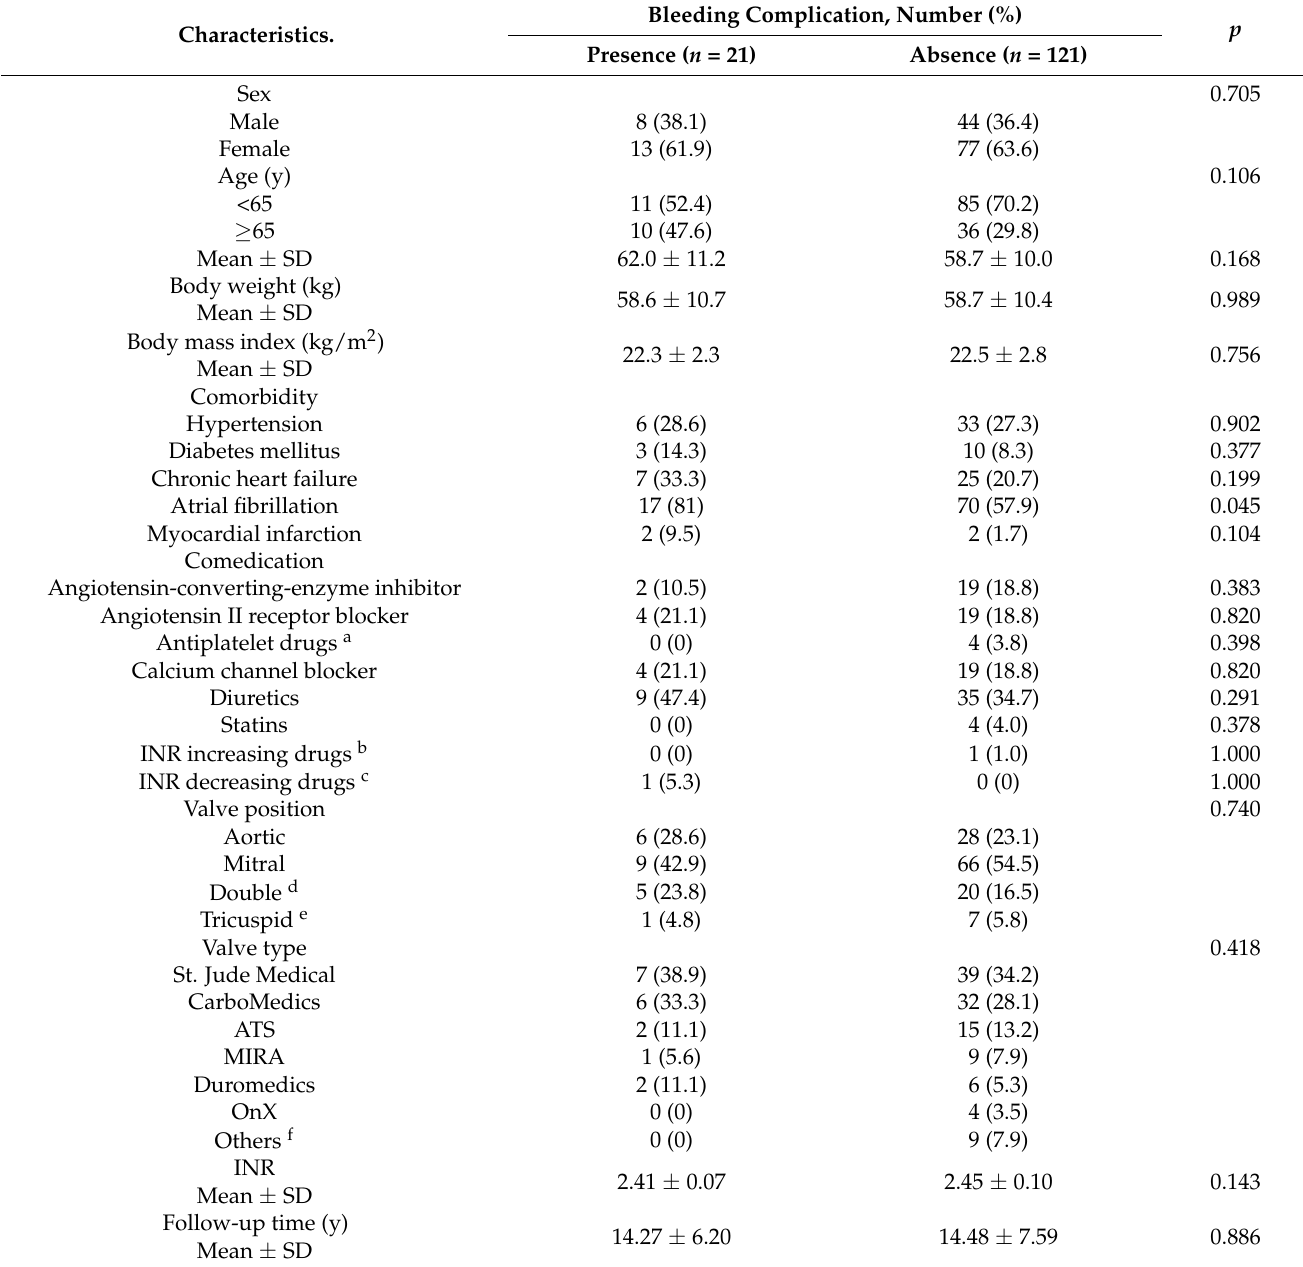
Table 1. Patient characteristics of study